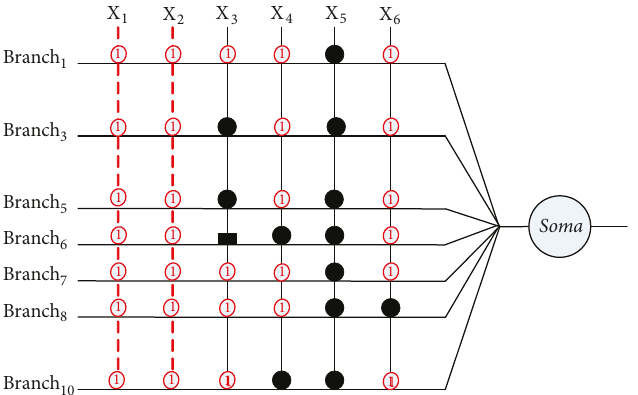
Figure 10: The dendritic morphology of the Qualitative Bankruptcy data set after synaptic pruning.